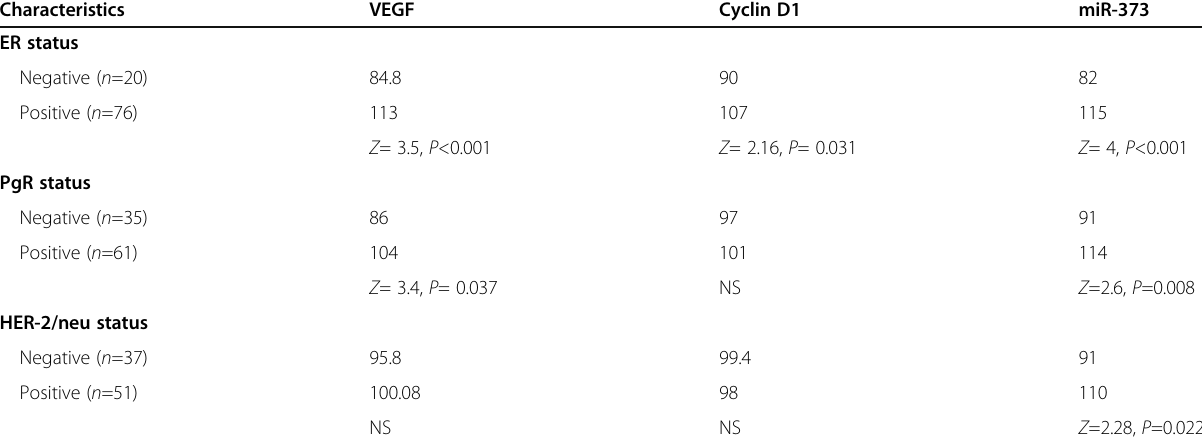
Table 3 Mean rank level of VEGF, cyclin D1, and miR-373 among the primary breast cancer group ( n =196)